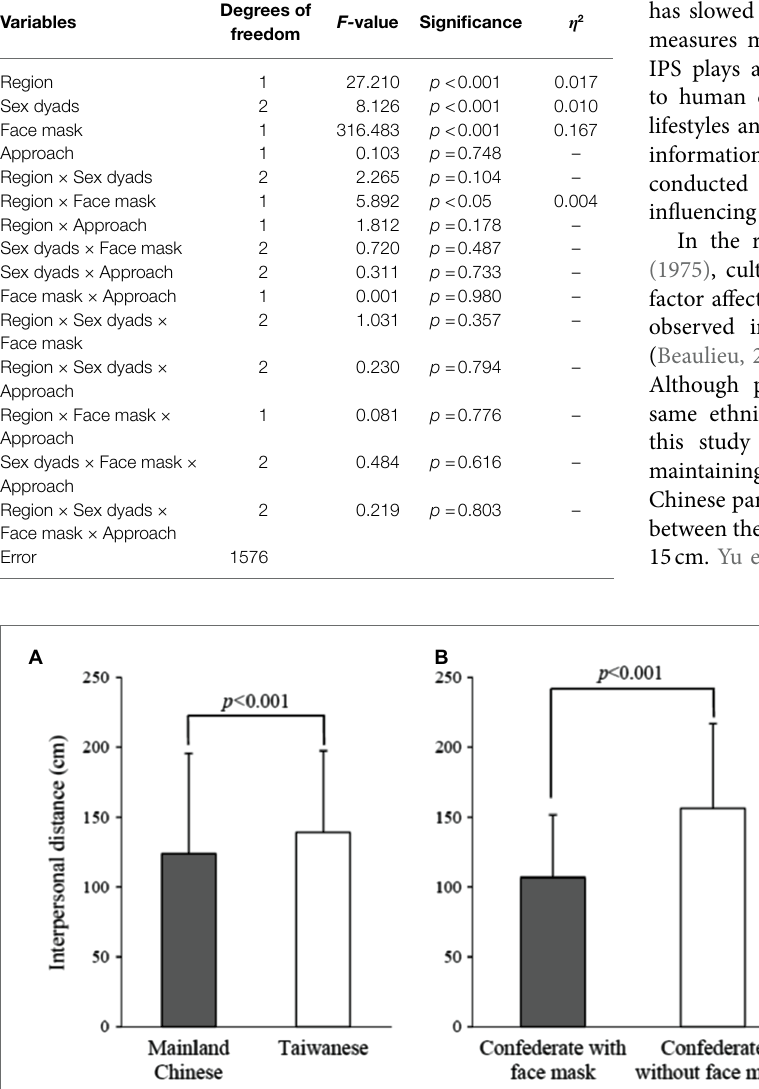
FIGURE 2 | Mean interpersonal distance with the standard deviations under each main effect including (A) region, (B) face mask, and (C) sex dyads compared using the Scheffé’s